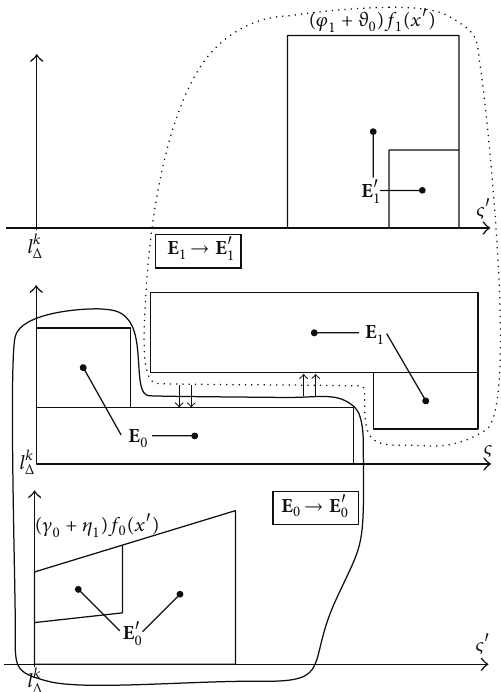
Figure 3: Scheme of redistribution of original samples during quantization, Ω is “true.”